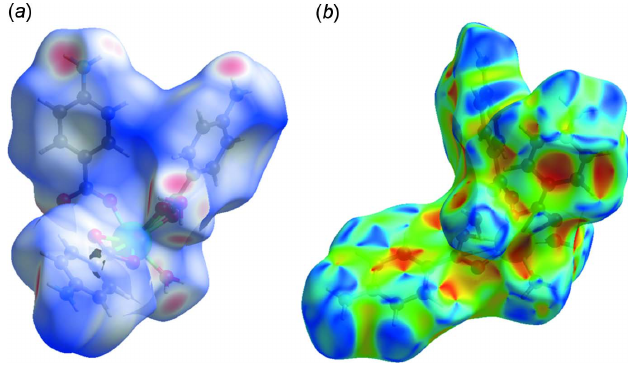
Figure 5 HS plotted over ( a ) d norm in the range (cid:5) 1.073 to 1.740 a.u. and ( b ) shape- index in the range (cid:5) 1 to 1 a.u.